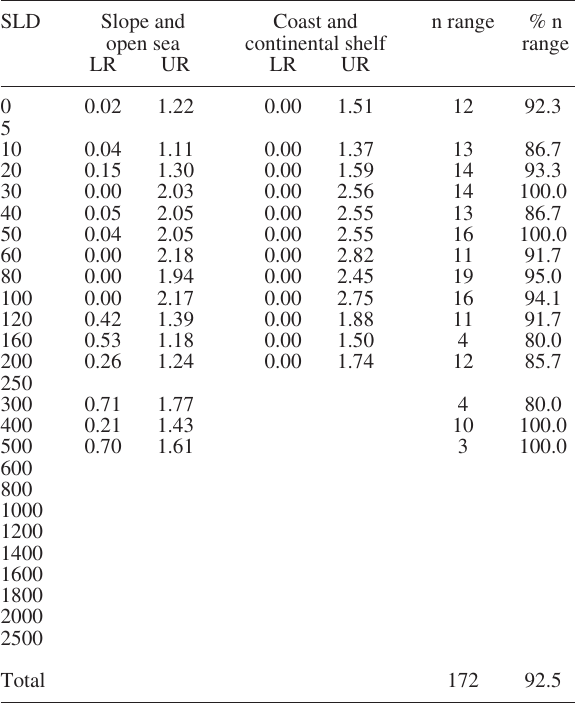
Table 13. – Ammonium concentration ( m M) ranges in the NW Mediterranean Sea in mixed water columns (stratification coeffi- cient = 1). Headers as in Table 7.